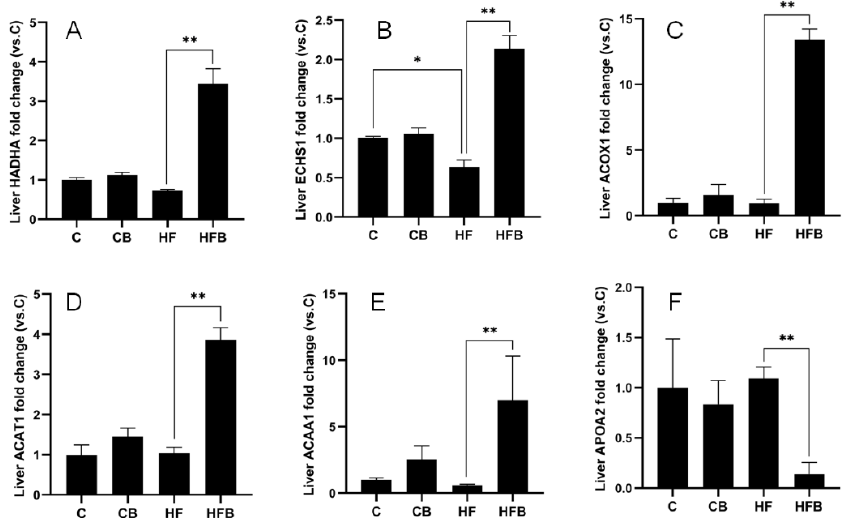
Figure 6. The relative expression HADHA ( A ), ECHS1 ( B ), ACOX1 ( C ), ACAT1 ( D ) and ACAA1 ( E ), APOA2 ( F ), as measured by MS protein profiling. The results are expressed as means ± SEM of the relative peak areas. * p < 0.05, ** p < 0.01.